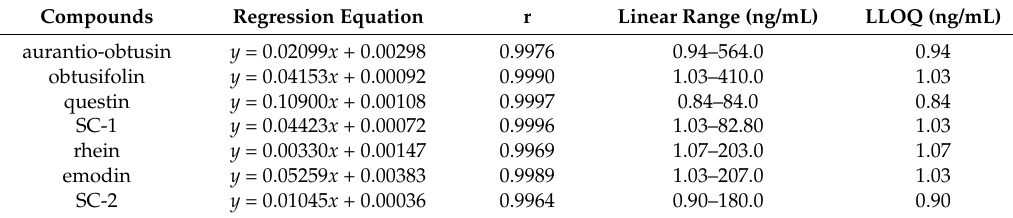
Table 1. The regression equations, linear ranges, LLOQs for the seven analytes in rat plasma. Compounds